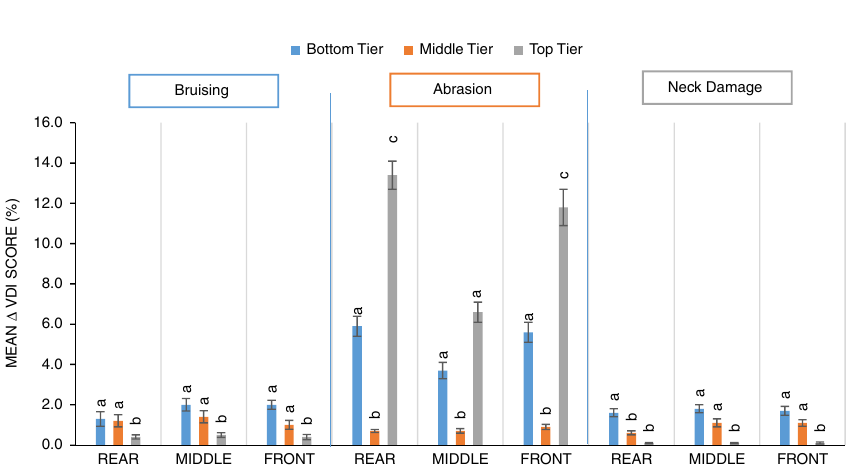
3.1.2 Effect of package position on mechanical damage during long-distance transport . Bruising in the bottom and middle tiers was significantly higher ( p o 0.05) compared to the top tier (Figure 4) during the interstate transport of packaged bananas from the growing region to the metropolitan DC. Similarly, neck damage was also significantly higher ( p o 0.05) in the bottom and middle tiers of each pallet compared to the top tiers. A significantly higher ( p o 0.05) level of abrasion damage was found in the top and bottom tiers compared to the middle tiers. The higher Δ VDI score for abrasion damage in the top tiers and bottom tiers of the pallets was mostly attributed to fruit rub damage.